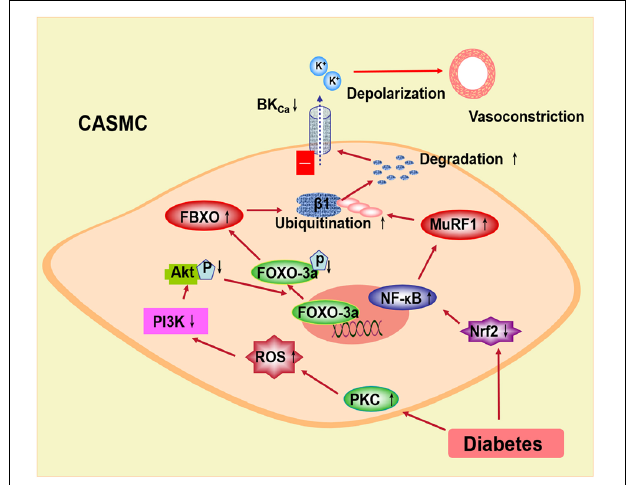
FIGURE 2 | Proposed signaling pathways underlying the BK channel downregulation through E3 ubiquitin ligases in coronary smooth muscle cells. In diabetes, increased PKC stimulation overproduced ROS, which inhibits the PI3k/Akt pathway. Decreased Akt phosphorylation suppresses FOXO-3a and then upregulates FBXO expression. Nrf2 is downregulated in diabetic coronary smooth muscle cells. Decreased Nrf2 upregulates NF- κ B and MuRF1. FBXO and MuRF1 are muscle-specific E3 ubiquitin ligases, which enhance the ubiquitination and the degradation of the BK β 1-subunit. The coronary vasoconstriction in diabetes is increased due to the impaired BK channel expression and function. PKC, protein kinase C; ROS, reactive oxygen species; PI3k, phosphatidylinositide 3-kinases; FOXO-3a, the forkhead box O family transcription factor-3a; FBXO, F-box protein; Nrf2, nuclear factor E2-related factor 2; NF- κ B, nuclear factor kappa B; MuRF1, muscle RING finger protein